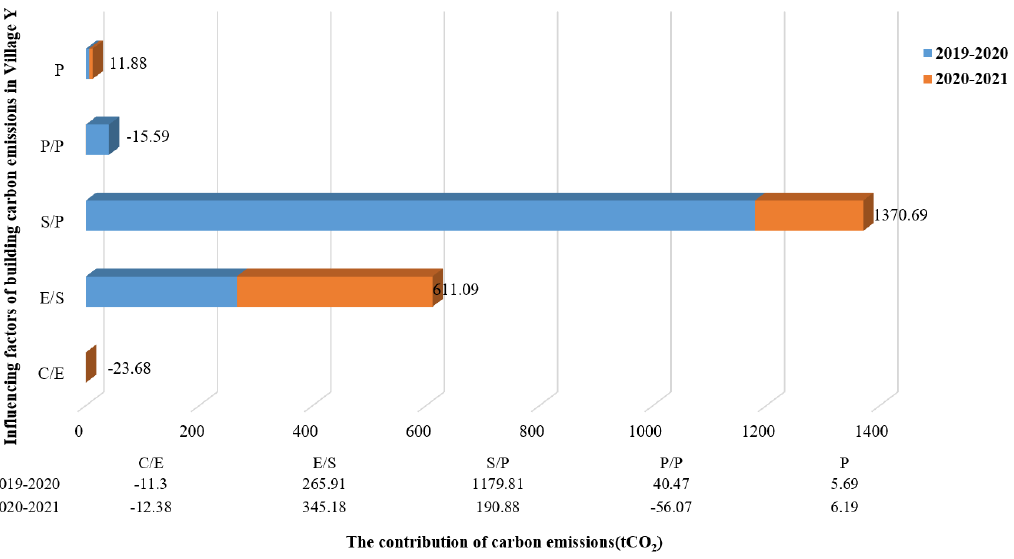
Figure 2. The contribution of building carbon emissions in village Y from 2019 to 2021. P: population size effect. P/P: population structure effect. S/P: per capita building area effect. E/S: building area energy intensity effect. C/E: carbon emission coefficient effect. Table 4. Results of LMDI decomposition of building carbon emissions in village Y from 2019 to 2021 (contribution rate, unit: %).